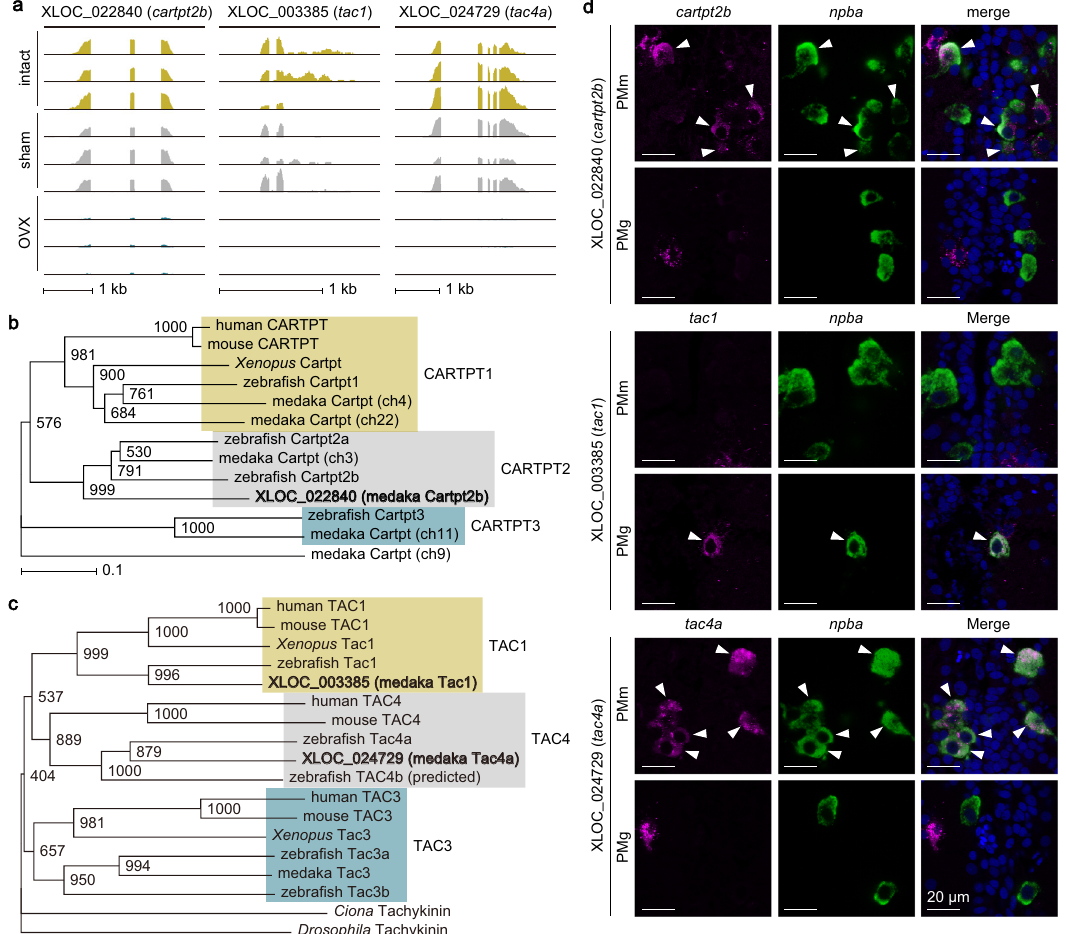
Fig. 1 Female-speci fi c preoptic neurons express multiple neuropeptides in an ovarian-dependent manner. a Integrative genomics viewer (IGV) images of RNA-seq reads from female-speci fi c npba -expressing neurons in the PMm/PMg of intact, sham-operated (sham), and ovariectomized (OVX) females ( n = 3 for each treatment) for XLOC_022840 ( cartpt2b ), XLOC_003385 ( tac1 ), and XLOC_024729 ( tac4a ). Phylogenetic trees showing the relationship of medaka Cartpt2b ( b ) and Tac1/Tac4 ( c ) to other known CARTPT and tachykinin family proteins. The number at each node indicates bootstrap values for 1000 replicates. Scale bar represents 0.1 substitutions per site. For species names and GenBank accession numbers, see Supplementary Table 1. d Representative micrographs showing the expression of catrpt2b , tac1 , and tac4 in npba -expressing neurons in the PMm (upper panels) and PMg (lower panels). Left and middle panels show images of, respectively, cartpt2b / tac1 / tac4a (magenta) and npba (green) expression in the same section; right panels show the merged images with nuclear counterstaining (blue). Arrowheads indicate representative neurons co-expressing cartpt2b / tac1 / tac4a and npba . Scale bars represent 20 μ